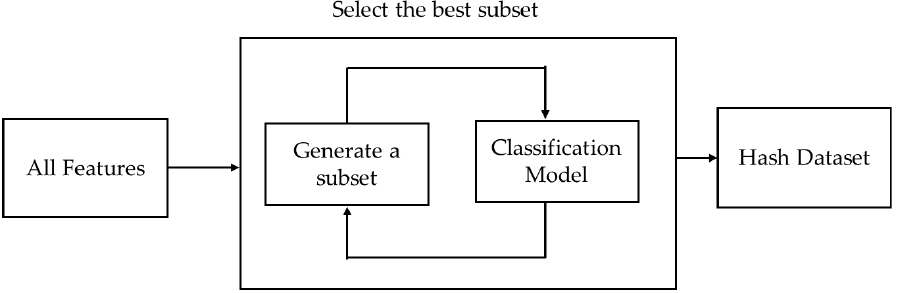
Figure 4. Wrapper method.